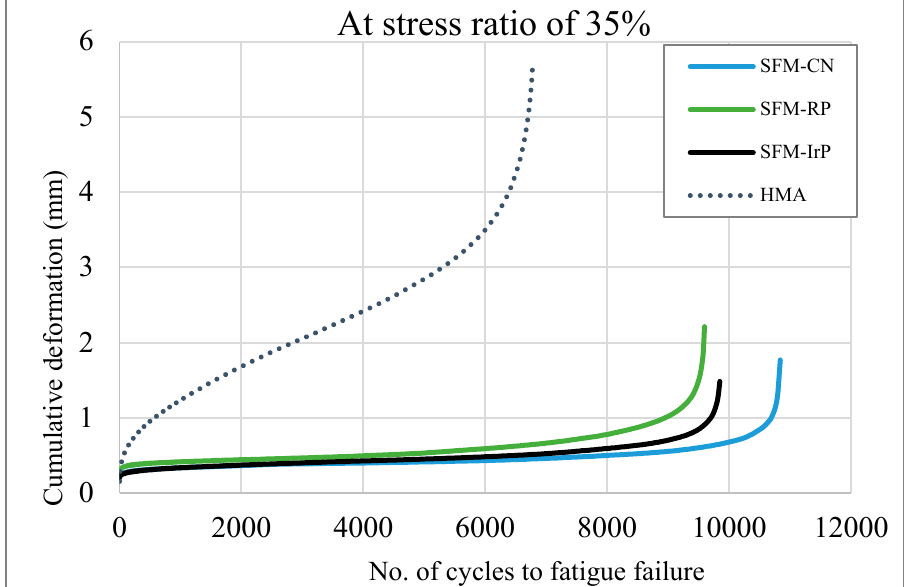
Figure 11. Number of fatigue cycles vs cumulative deformation at 35% stress ratio .